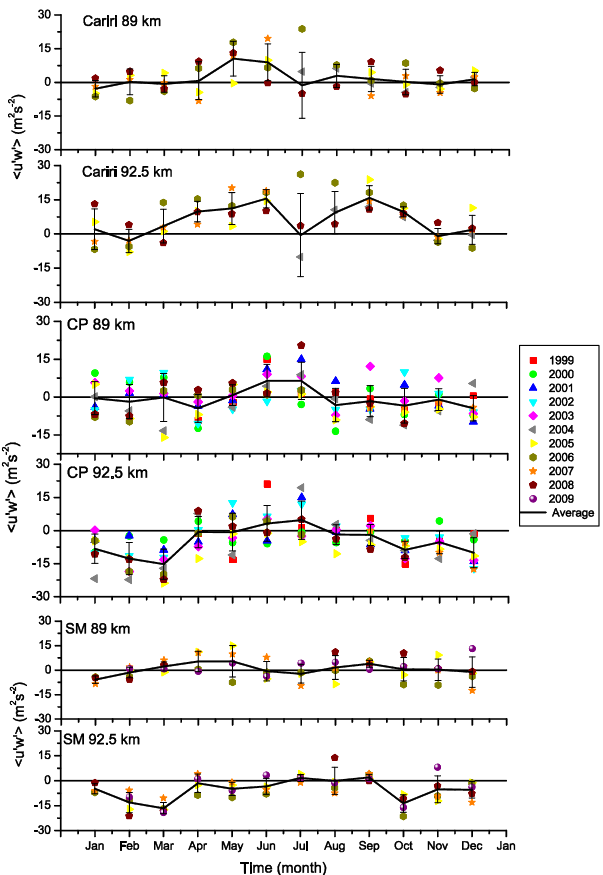
Figure 4. Monthly mean zonal momentum fluxes for the two height layers where the meteor counting rates are largest, at each site. The top panels show the results for São João do Cariri (Cariri, low lati- tude), the center panels are for Cachoeira Paulista (CP, middle–low latitude), and the bottom are for Santa Maria (SM, middle latitude). Error bars denote the standard deviation.